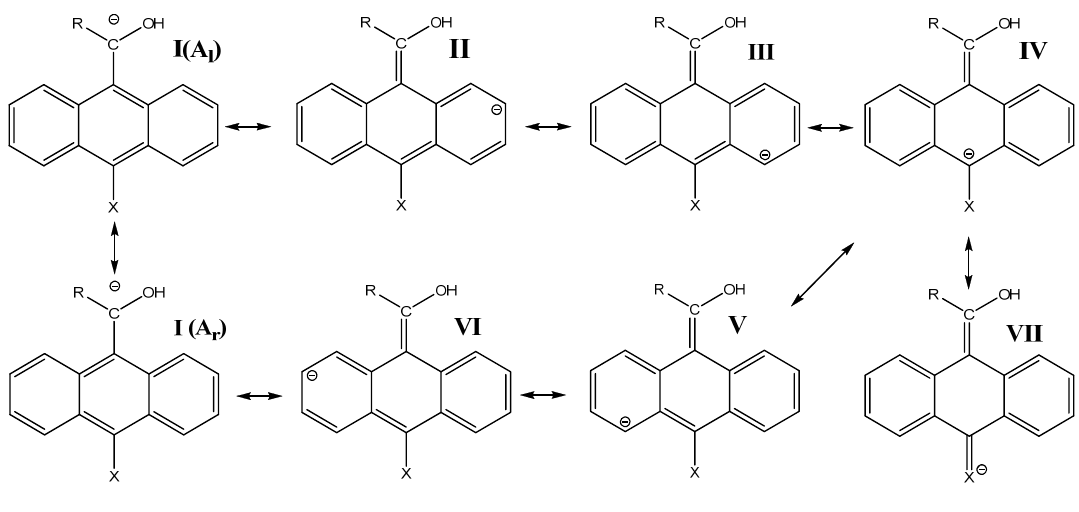
Table 2. Linear correlation equation between Δ for 1b – 1g . The linear correlation equation for 2b – 2g is given in parenthesis. or χ XC6H4 Δ G ° = b + mY(values in kcal mol − 1 acid